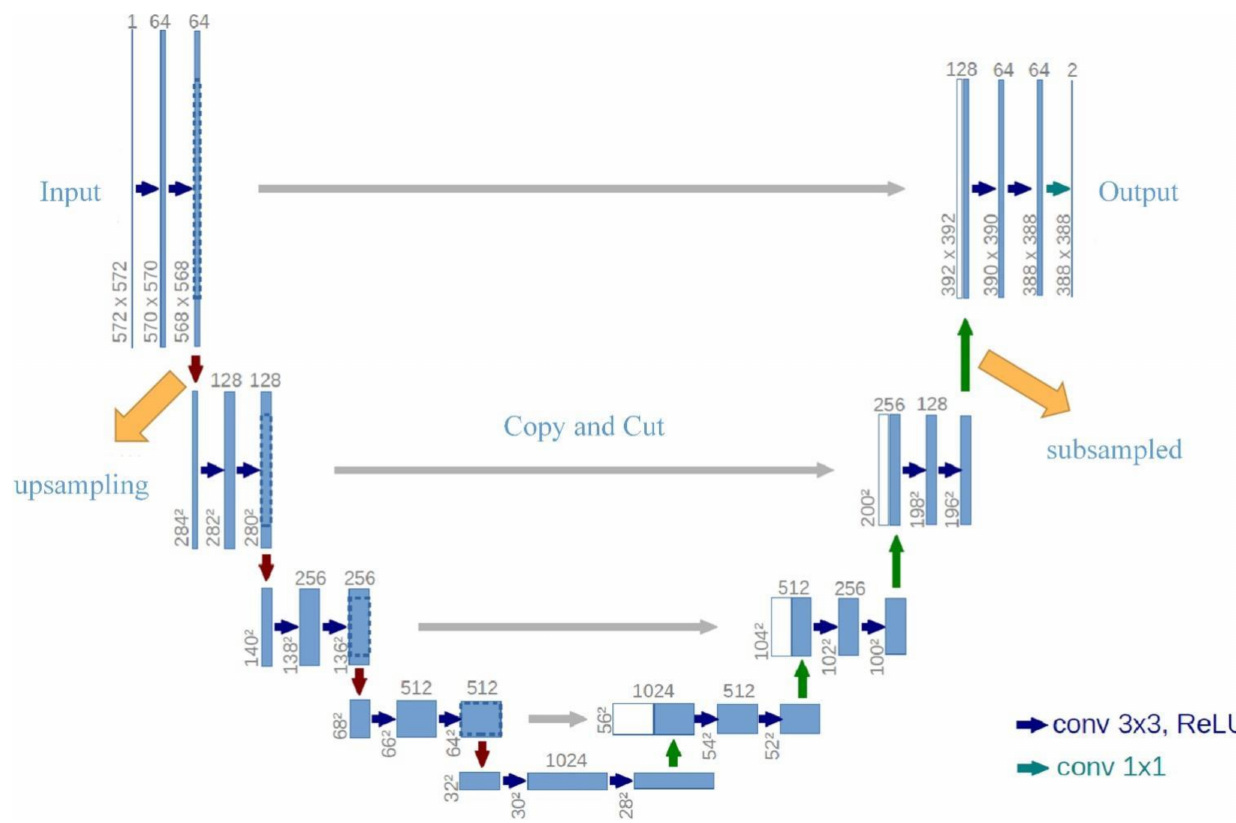
Figure 3. U-Net network structure.